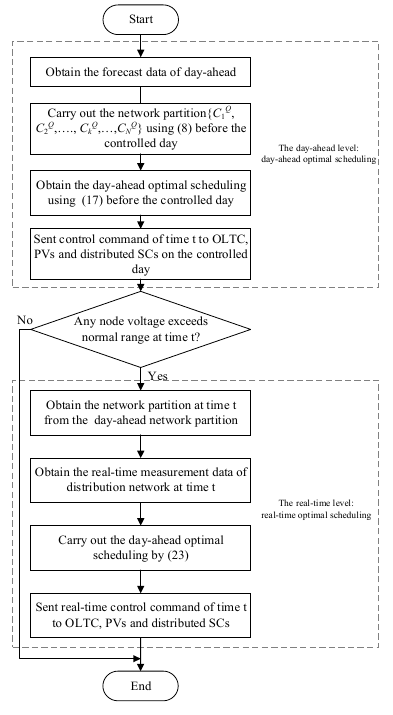
Figure 3. Flowchart of the proposed voltage control.